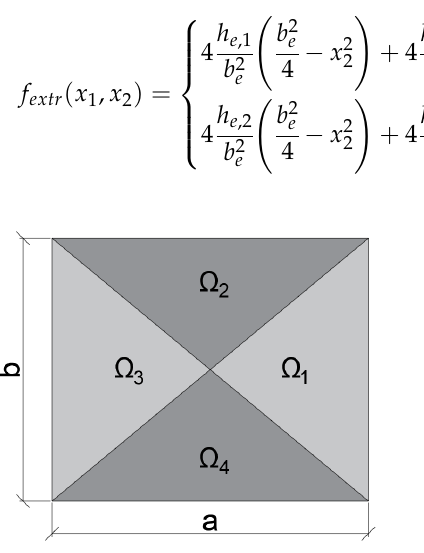
Figure 13. Parition of the domain Ω .